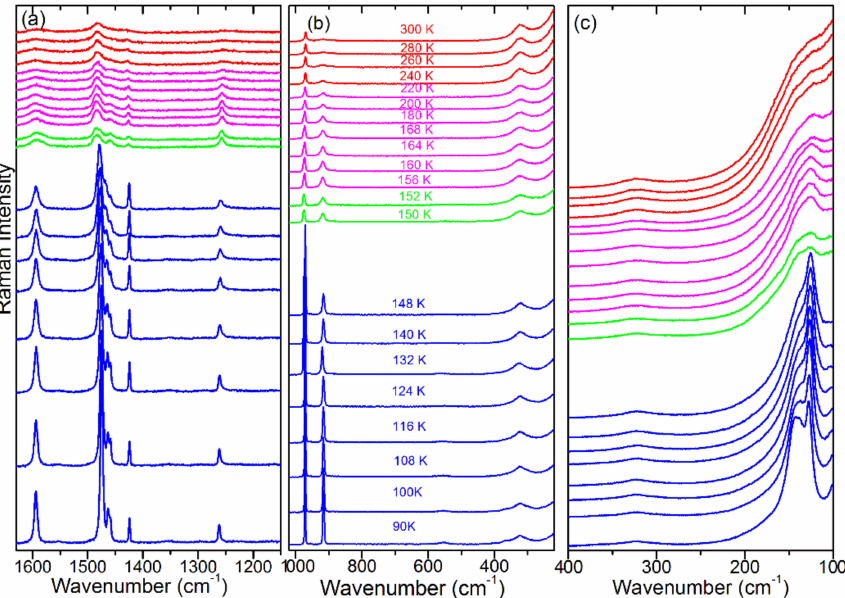
Figure 1. Temperature-dependent Raman spectra in the ( a ) 1630–1150 cm − 1 , ( b ) 1020–220 cm − 1 and ( c ) 400–100 cm − 1 range. Red, magenta, green and blue colours correspond to the Pm 3 m , I 4/ mcm , P 4/ mmm (or Imma ) and Pnma phases, respectively.